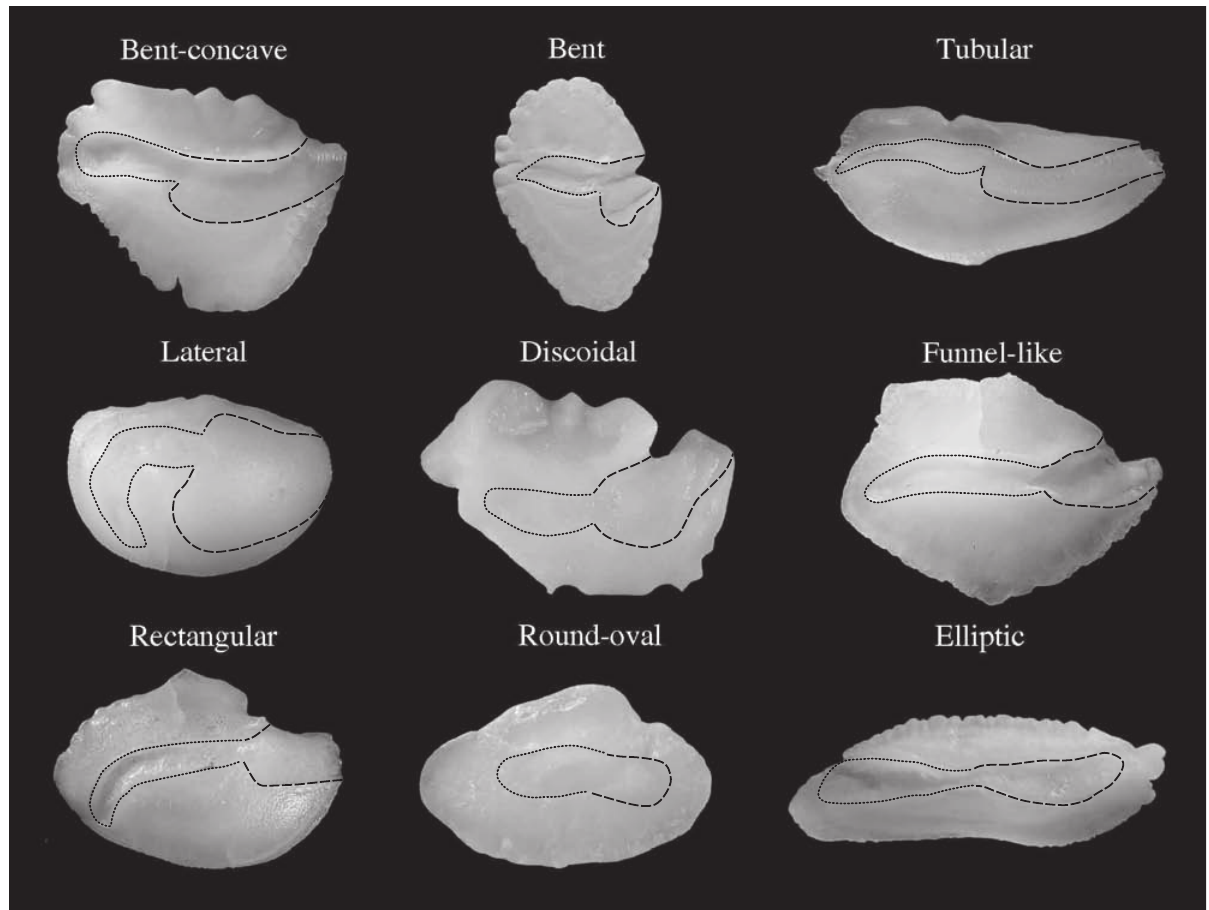
Fig. 6. – Terms used to define the ostial region of the sulcus acusticus (ostium limited by a discontinuous line; cauda limited by a dashed